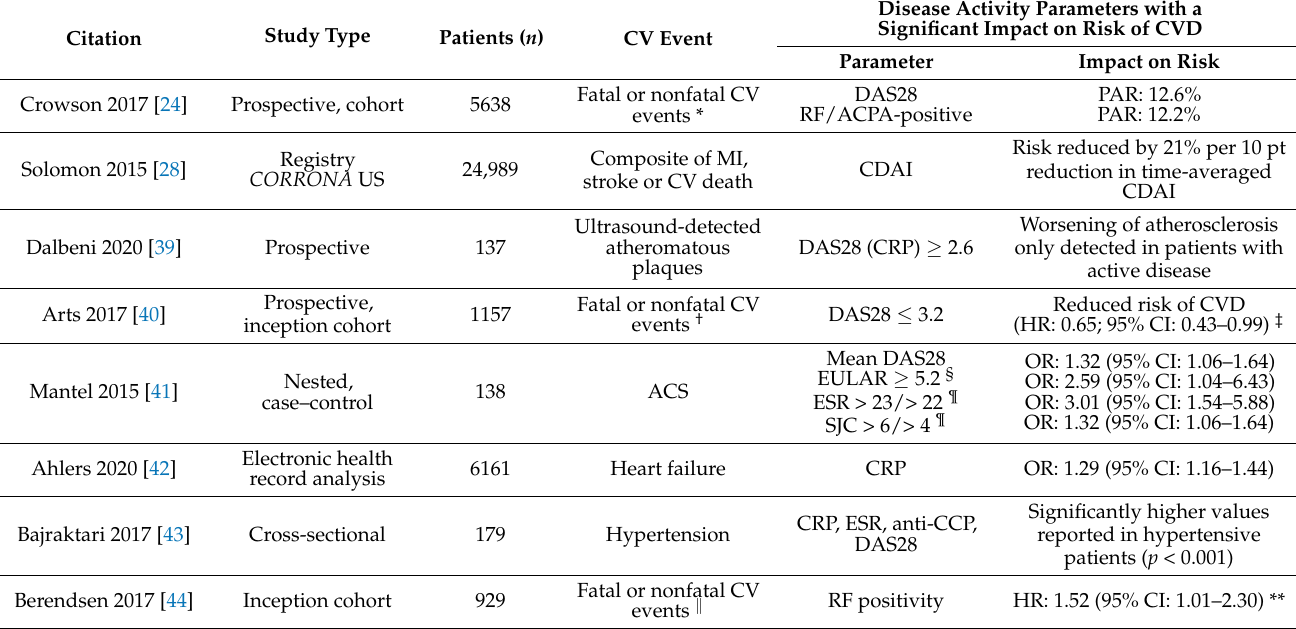
Table 2. Studies reporting an association between rheumatoid arthritis disease activity and risk of cardiovascular disease.